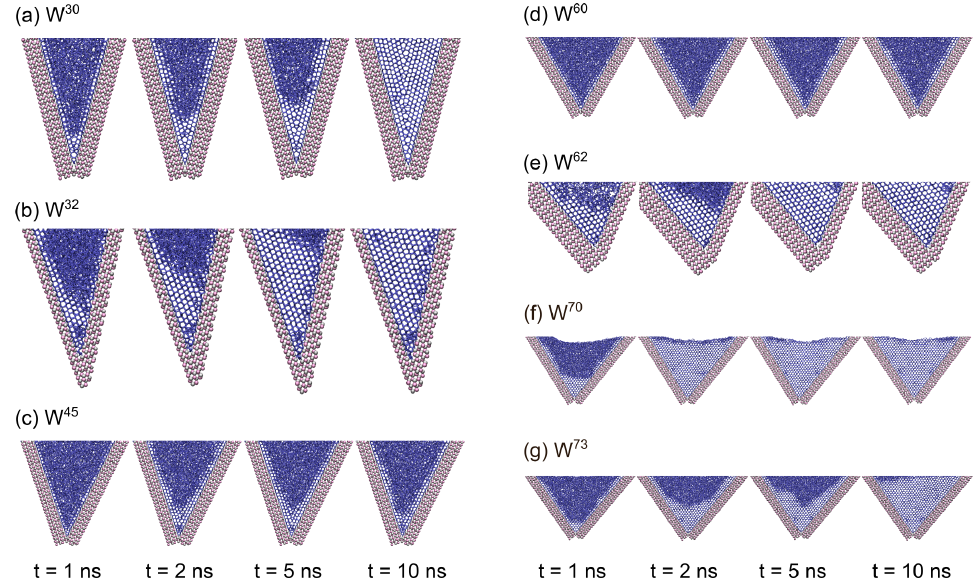
Figure 6. Simulation snapshot details of ice growth at times t = 1, 2, 5 and 10ns in wedge systems (a) W 30 , (b) W 32 , (c) W 45 , (d) W 60 , (e) W 62 , (f) W 70 and (g) W 73 , using the mW model. Ag and I are colored in silver and pink, respectively, and the hydrogen bond network between mW water molecules is indicated by blue sticks.